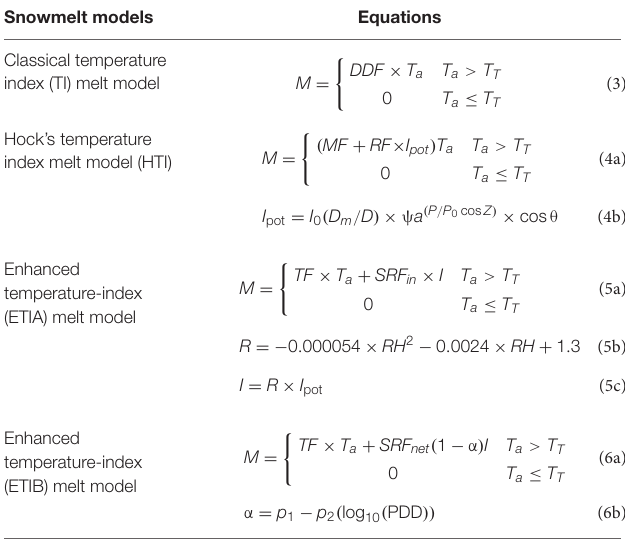
TABLE 2 | Melt models equations used in this